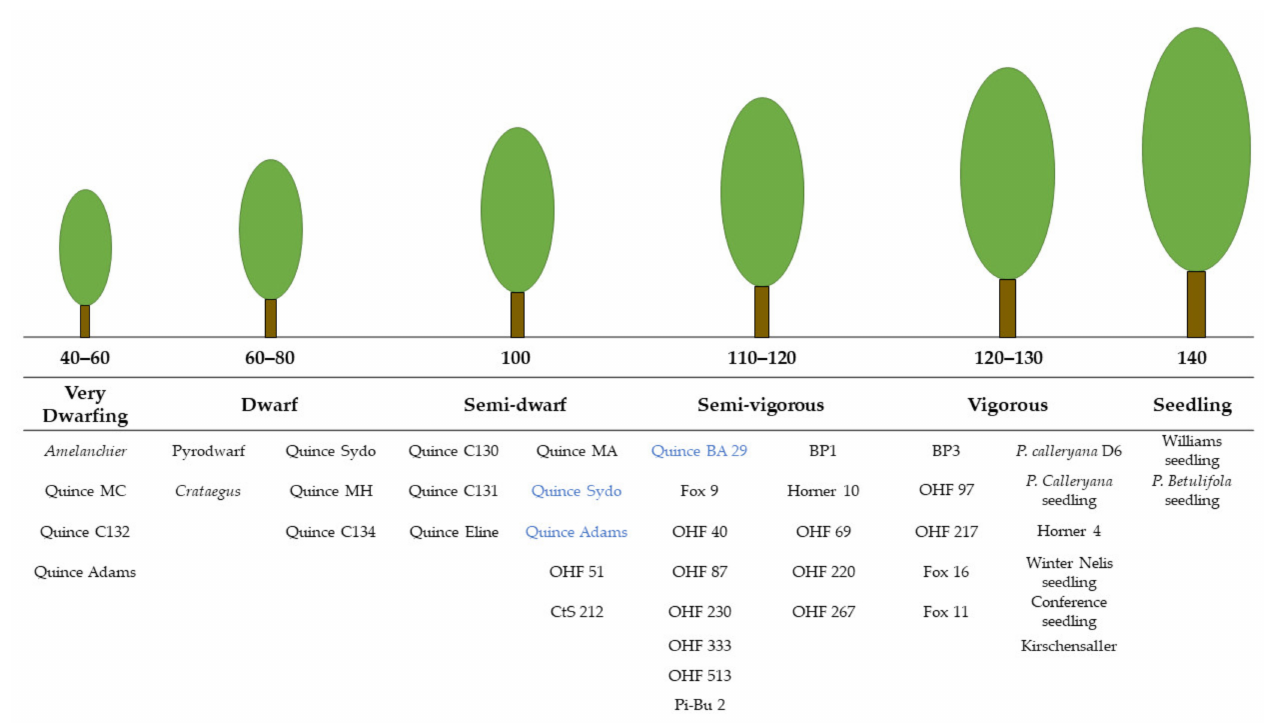
Figure 1. Main rootstocks utilized and their vigor compared to quince MA in Italy. The accessions in blue express the vigor in a different district of production (Ebro